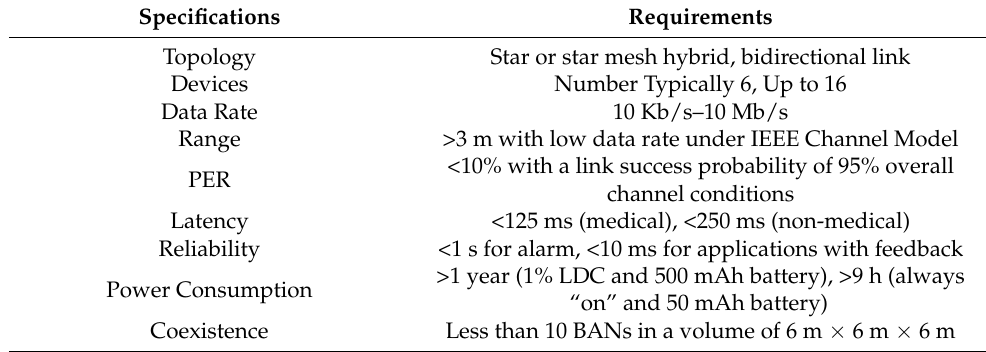
Table 7. Main specifications for WBAN